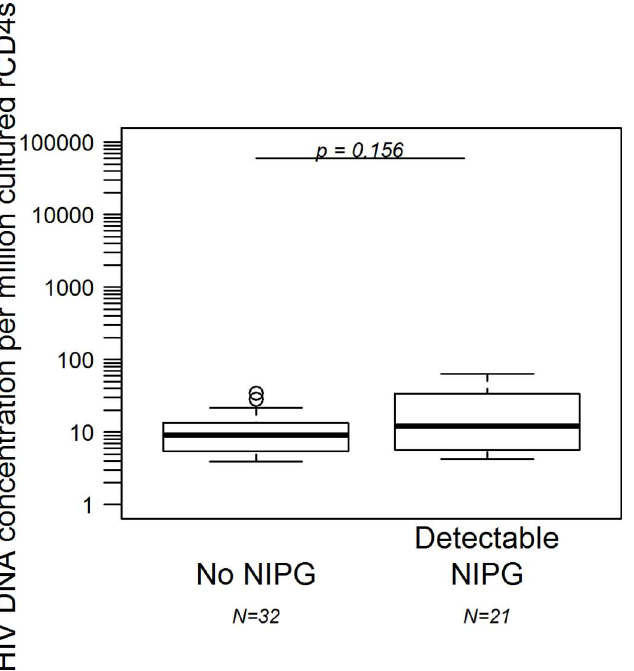
Fig 4. HIV DNA concentrations from cultured resting CD4+ T cell QVOA wells with and without NIPG. “N” represents the numberof QVOA culture